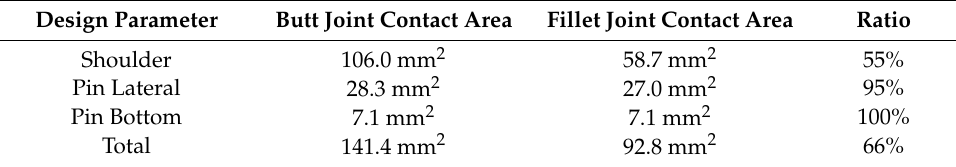
Figure 7. Area where frictional heat is generated by FSW method: ( a ) Major geometry of the tool; ( b ) friction area of tool in butt FSW; ( c ) friction area of tool in fillet joint FSW. Table 1. Design variables for heat source calculation.